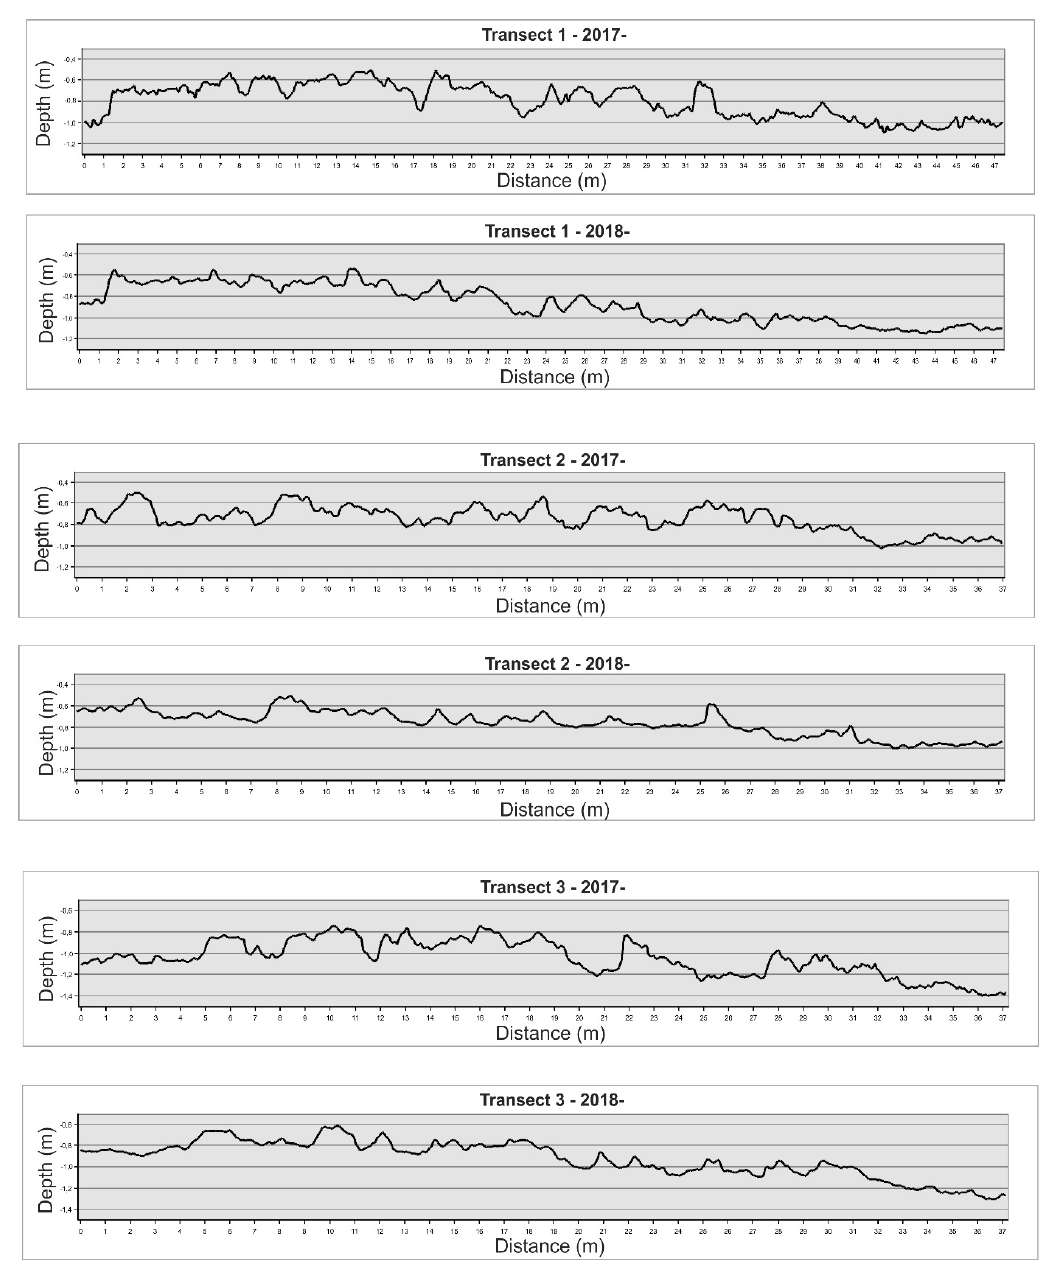
Figure A1. Comparison of terrain profiles along the three transects, T1–T3, in Area 4 (Figure 6) between 2017 and 2018.